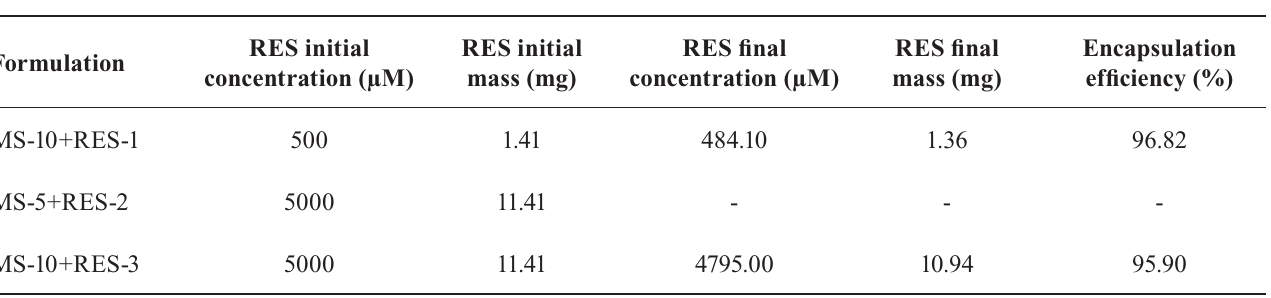
TABLE II - Encapsulation efficiency